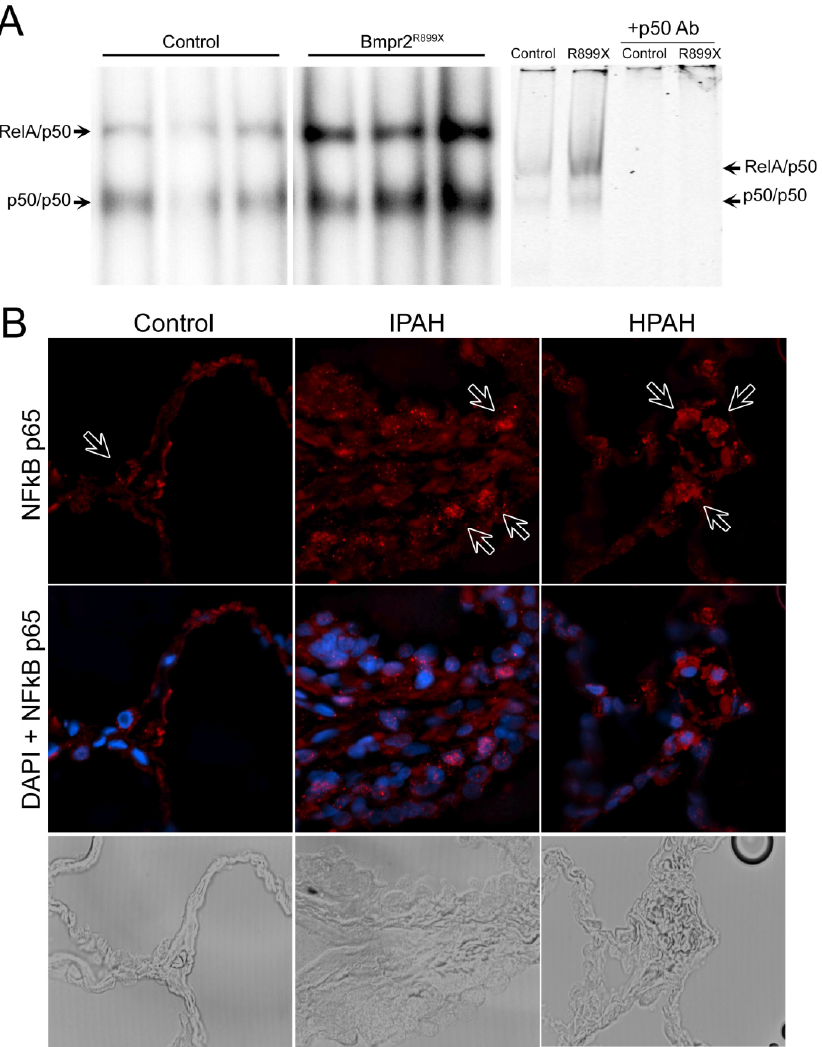
counter-regulatory: NF- κ B activation results in suppression of BMP signaling, as well as suppression of BMP inhibitor Grem2, with the result that this suppression is, in normal mice, temporary. Figure 1. NF- κ B activation is present in pulmonary arterial hypertension. ( A , left ) Electrophoretic Mobility Shift Assay (EMSA) using lung nuclear protein extracts from Rosa26-only (control) or Rosa26-Bmpr2 R899X mice with elevated right ventricular systolic pressures (RVSP). Two NF- κ B bands composed of RelA/p50 heterodimers and p50 homodimers are identified. Each lane is the result from a separate mouse. White space indicates non-adjacent lanes, but identically processed and from the same blot. ( A , right ) The rightmost four lanes demonstrate specificity of the EMSA bands using p50 antibodies to eliminate the p50 bands. ( B ) Lung from control ( left ), idiopathic PAH (IPAH), and heritable PAH (HPAH) (42) patients shows that the latter conditions are associated with increased NF- κ B and increased nuclear localization (red) in some